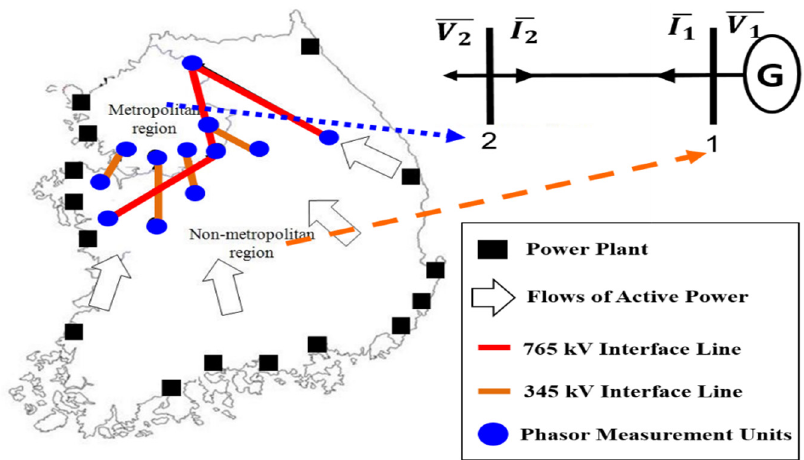
Figure 12. Korean power system grid and the major transmission lines.